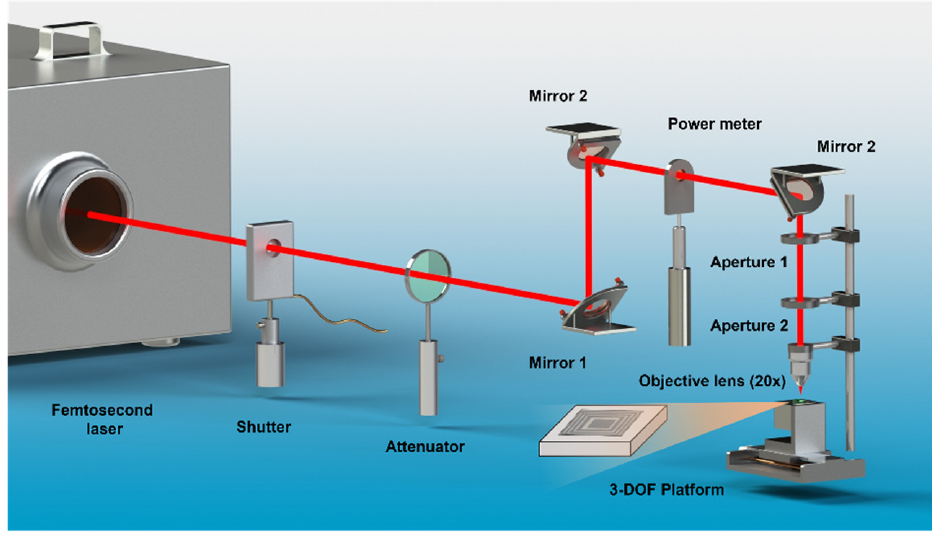
Figure 3. Schematic diagram of the femtosecond laser direct writing experimental system.